Question: Looking at the figure, what chart type is it?
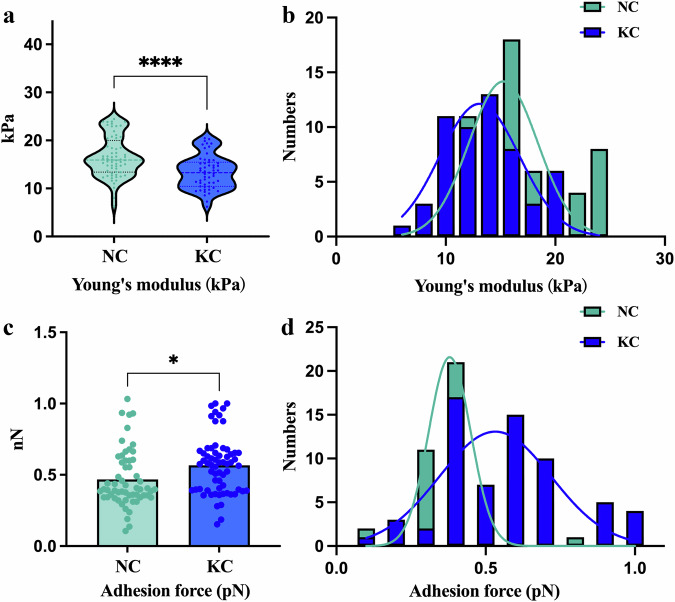
Answer: scatter